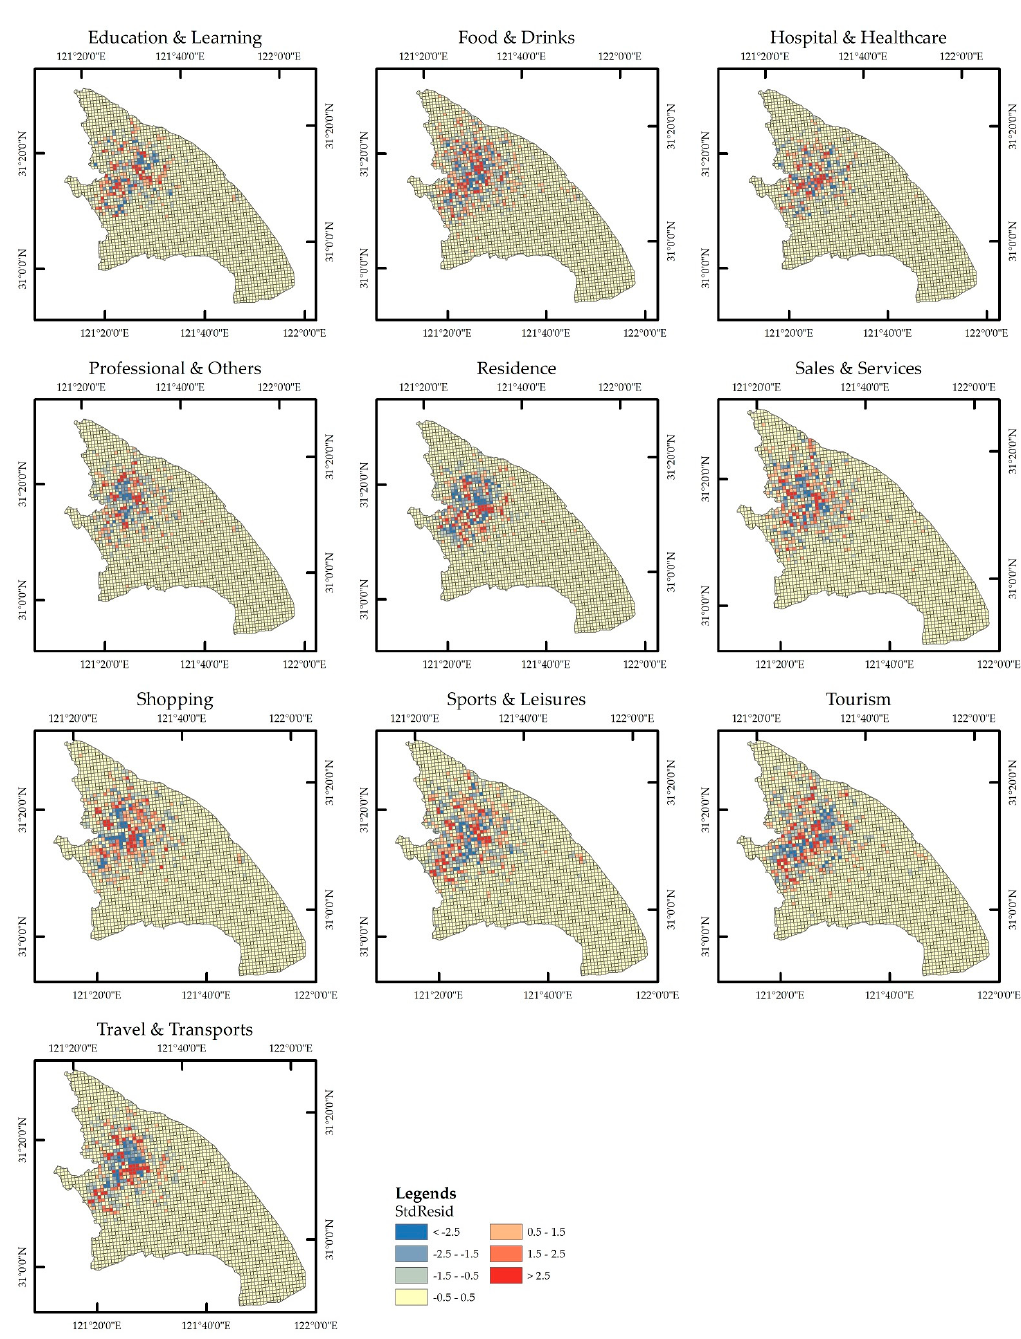
Figure 16. Spatial distribution of activities during the weekends in Shanghai.